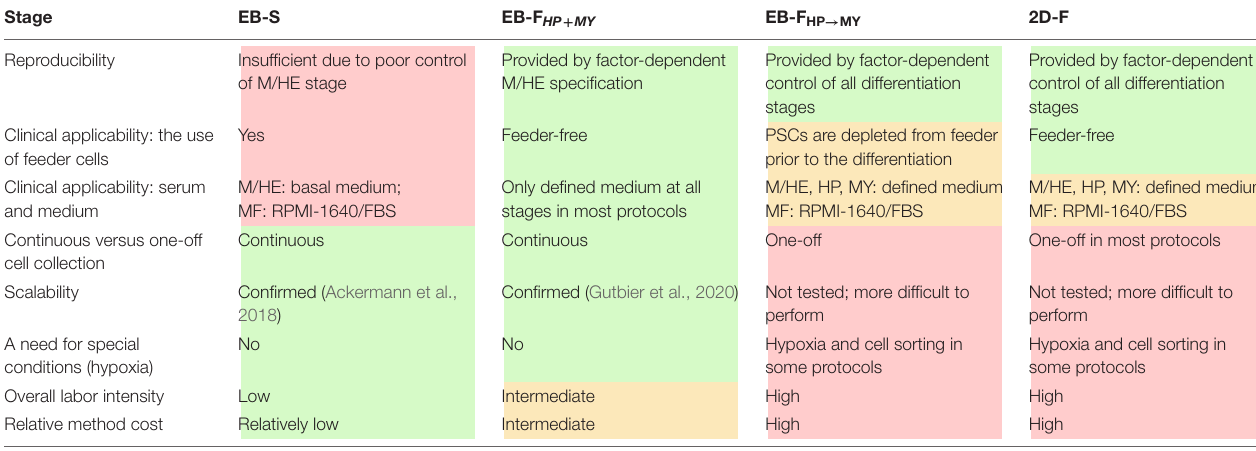
TABLE 8 | Advantages and limitations of the main groups of iMph differentiation